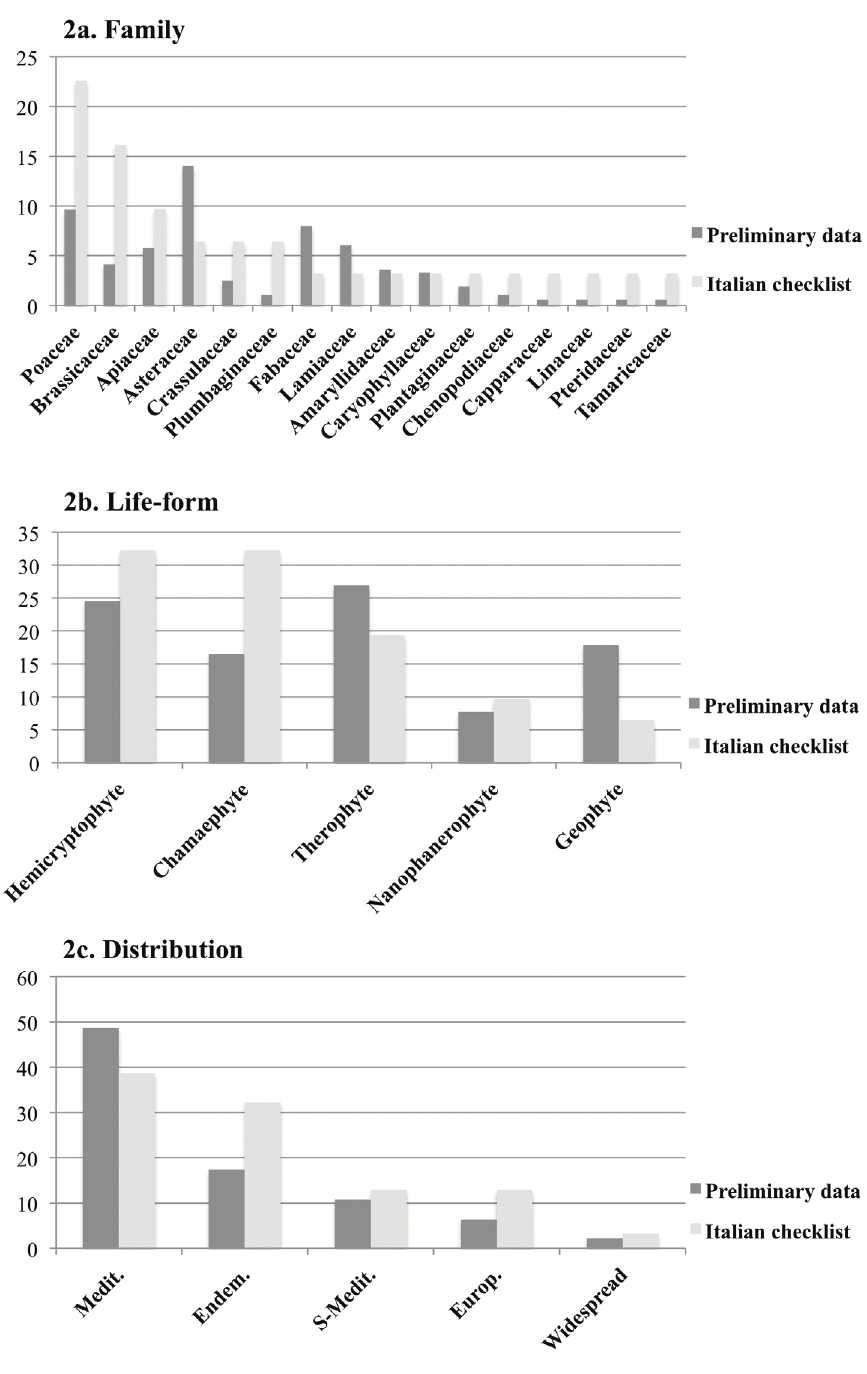
Figure 2. Percentage of taxa grouping by taxonomic families, life-forms and distribution and comparison between gypsophilous flora and preliminary